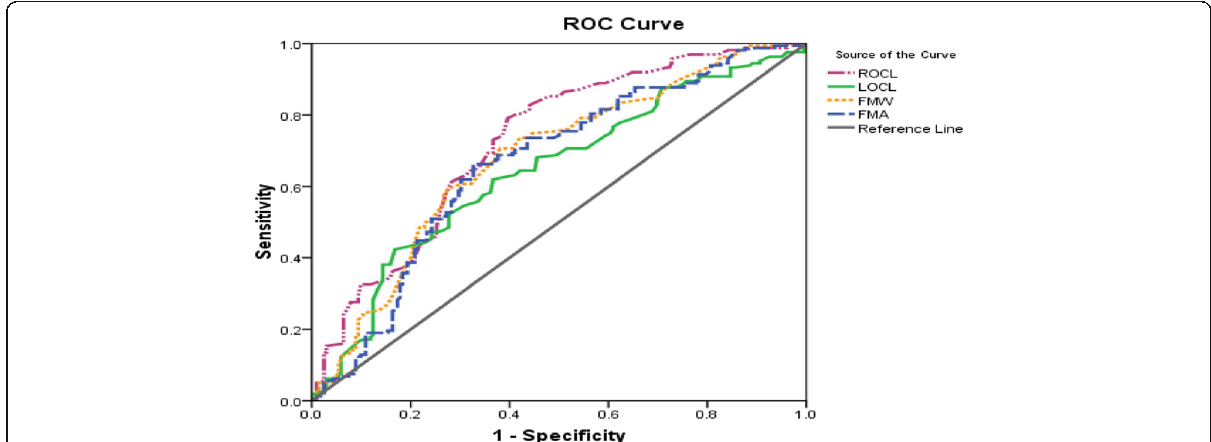
Fig. 2 Receiver operating characteristic curve (ROC) for the significant variables (ROCL=0.725, LOCL=0.642, FMW=.682, FMA=.664) among all the measured parameters of foramen magnum and occipital condyles in the studied Egyptian population ( n =367). ROCL: right occipital condylar length, LOCL: left occipital condylar length, FMW: foramen magnum width, FMA: foramen magnum area